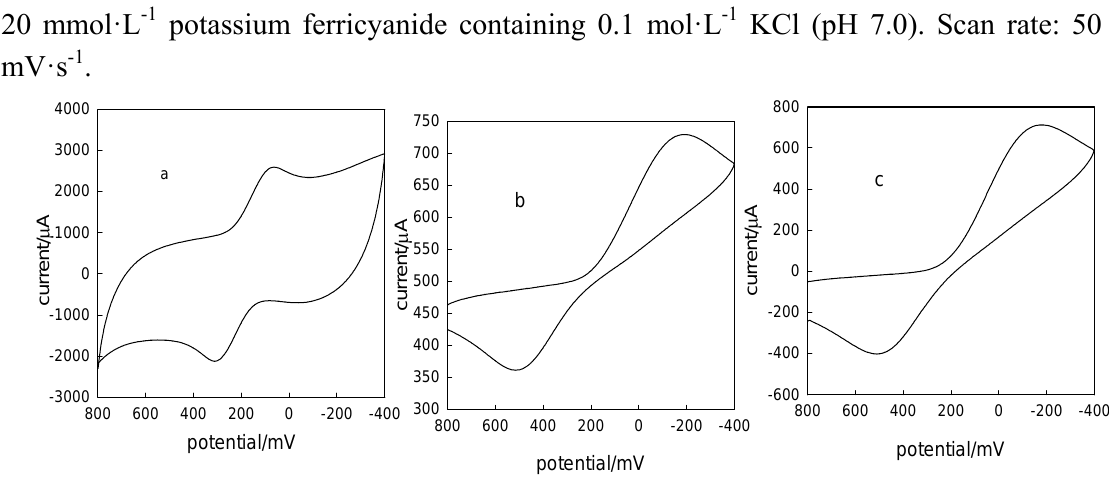
Figure 5. Cyclic voltammograms obtained with the CLTNPE (a), GC (b) and CPE (c) in 20 mmol·L -1 ascorbic acid containing 0.1 mol·L -1 KCl (pH 7.0) Scan rate: 50 mV·s -1